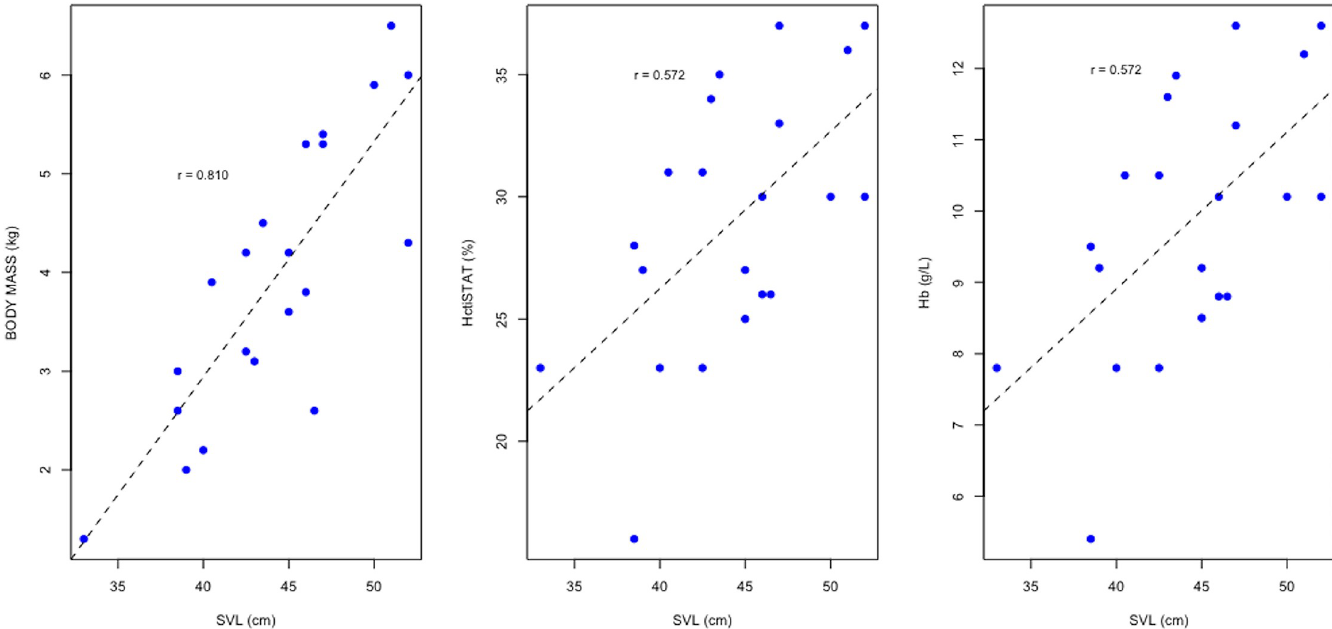
Fig 2. Linear regression and correlations of iSTAT hematocrit and hemoglobin with C . pallidus body size (SVL = Snout vent length). Linear regression models: BODY MASS (KG) = -6.60088 + 0.23858 (S E = 0.03744) � SVL (t = 6.372, p = 4.11e-06); HctiSTAT (%) = 0.4580 + 0.6445 (S E = 0.2034) � SVL (t = 3.168, p = 0.00507);